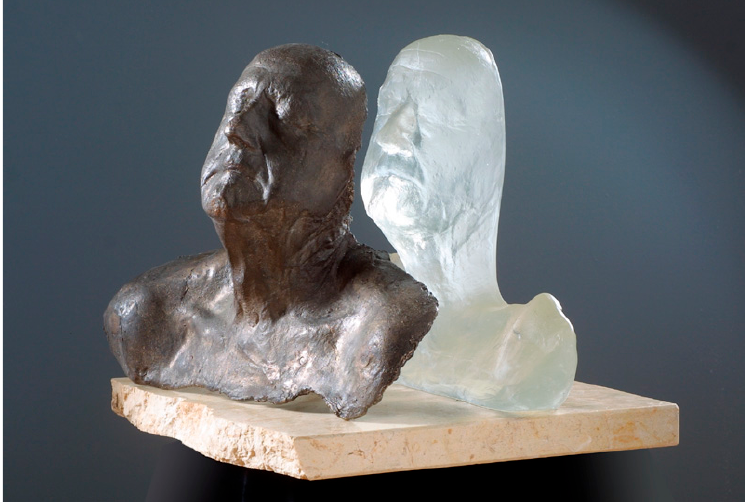
Figure 1. Goshka Bialek; What’s Left? 2004 ; cast bronze and glass on marble base; photographed by Tim Adams, used by permission.